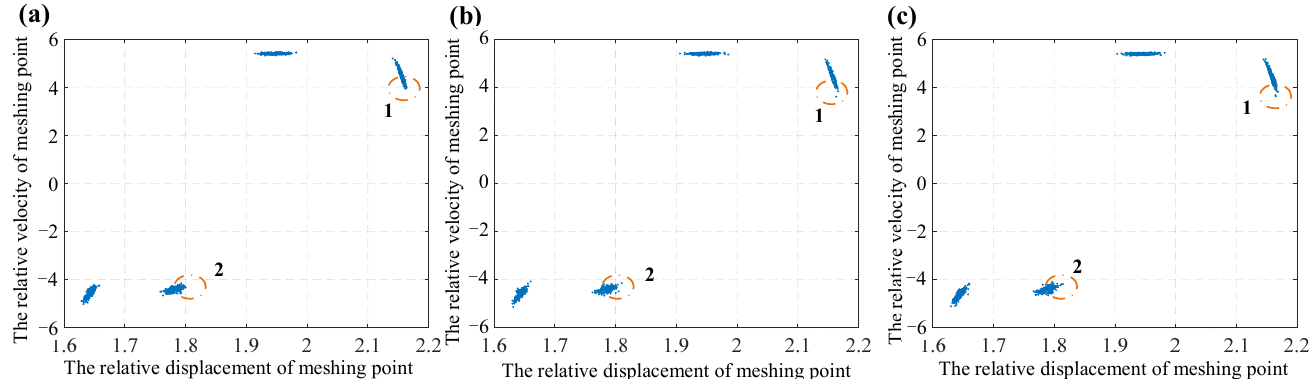
Figure 17. Poincare section diagram with different μ m . ( a ) μ m = 0.02. ( b ) μ m = 0.06. ( c ) μ m = 0.1.